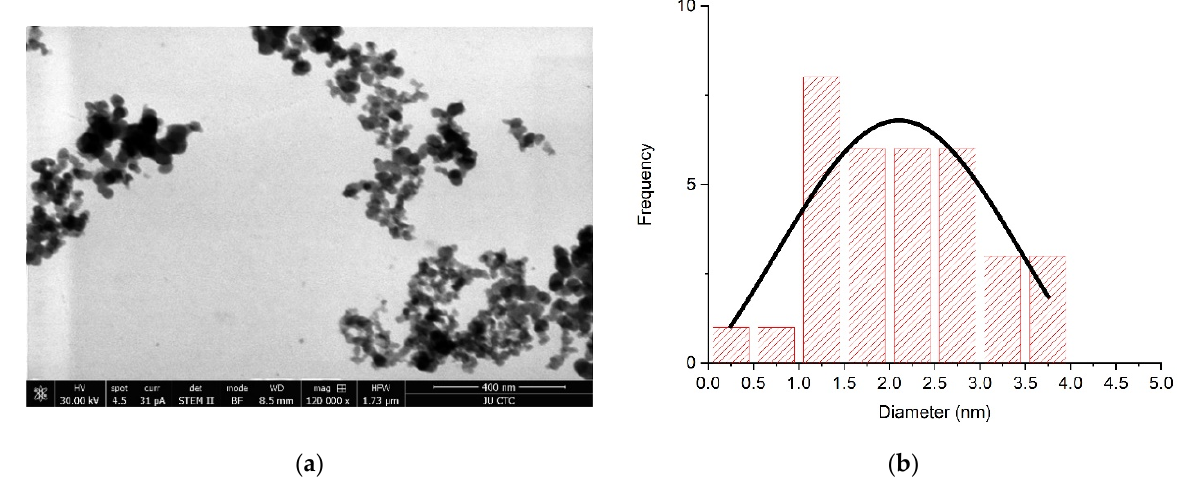
2 √ e − 2 ( x − xc w ) π w 2 (cid:3050)(cid:3495) (cid:3343)